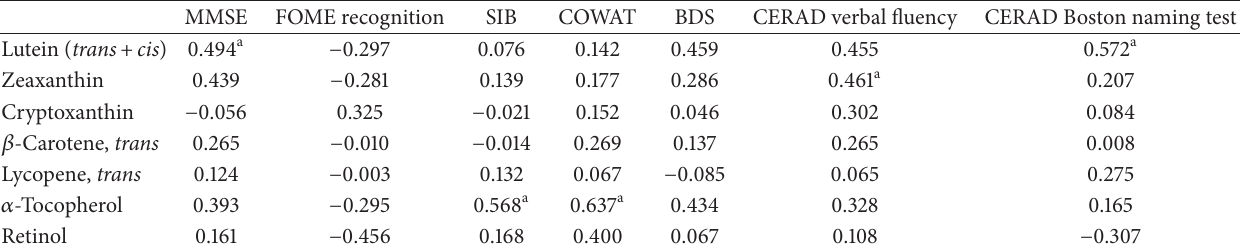
Table 6: Cross-sectional relationship between concentrations of carotenoids, 𝛼 -tocopherol, and retinol in the cortex (average concentrations of the frontal, occipital, and temporal cortices) and premortem measures of cognitive function in subjects with normal cognitive function, mild memory loss, and MCI who completed the cognitive function tests a year prior their death ( 𝑛 = 21